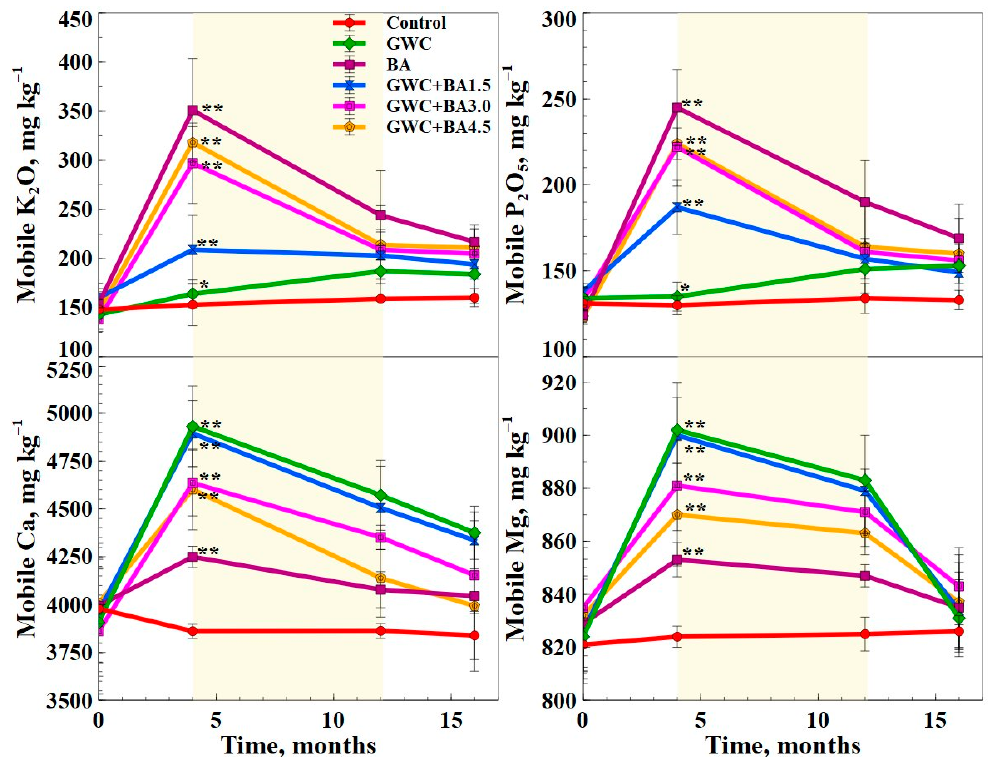
Figure 2. Change in the chemical composition of soil mobile K 2 O, P 2 O 5 , Ca, and Mg after GWC, BA, and GWC + BA application. The control represents no additives. The shaded area represents the chemical soil composition after the crop was harvested. * = significance at p ≤ 0.05 and ** = significance at p < 0.01. BA—biofuel ash; GWC—green waste compost; GWC + BA1.5—green waste compost (20 t ha − 1 ) + biofuel ash (1.5 t ha − 1 ); GWC+BA3.0—green waste compost (20 t ha − 1 ) + biofuel ash (3.0 t ha − 1 ); GWC+BA4.5—green waste compost (20 t ha − 1 ) + biofuel ash (4.5 t ha − 1 ).